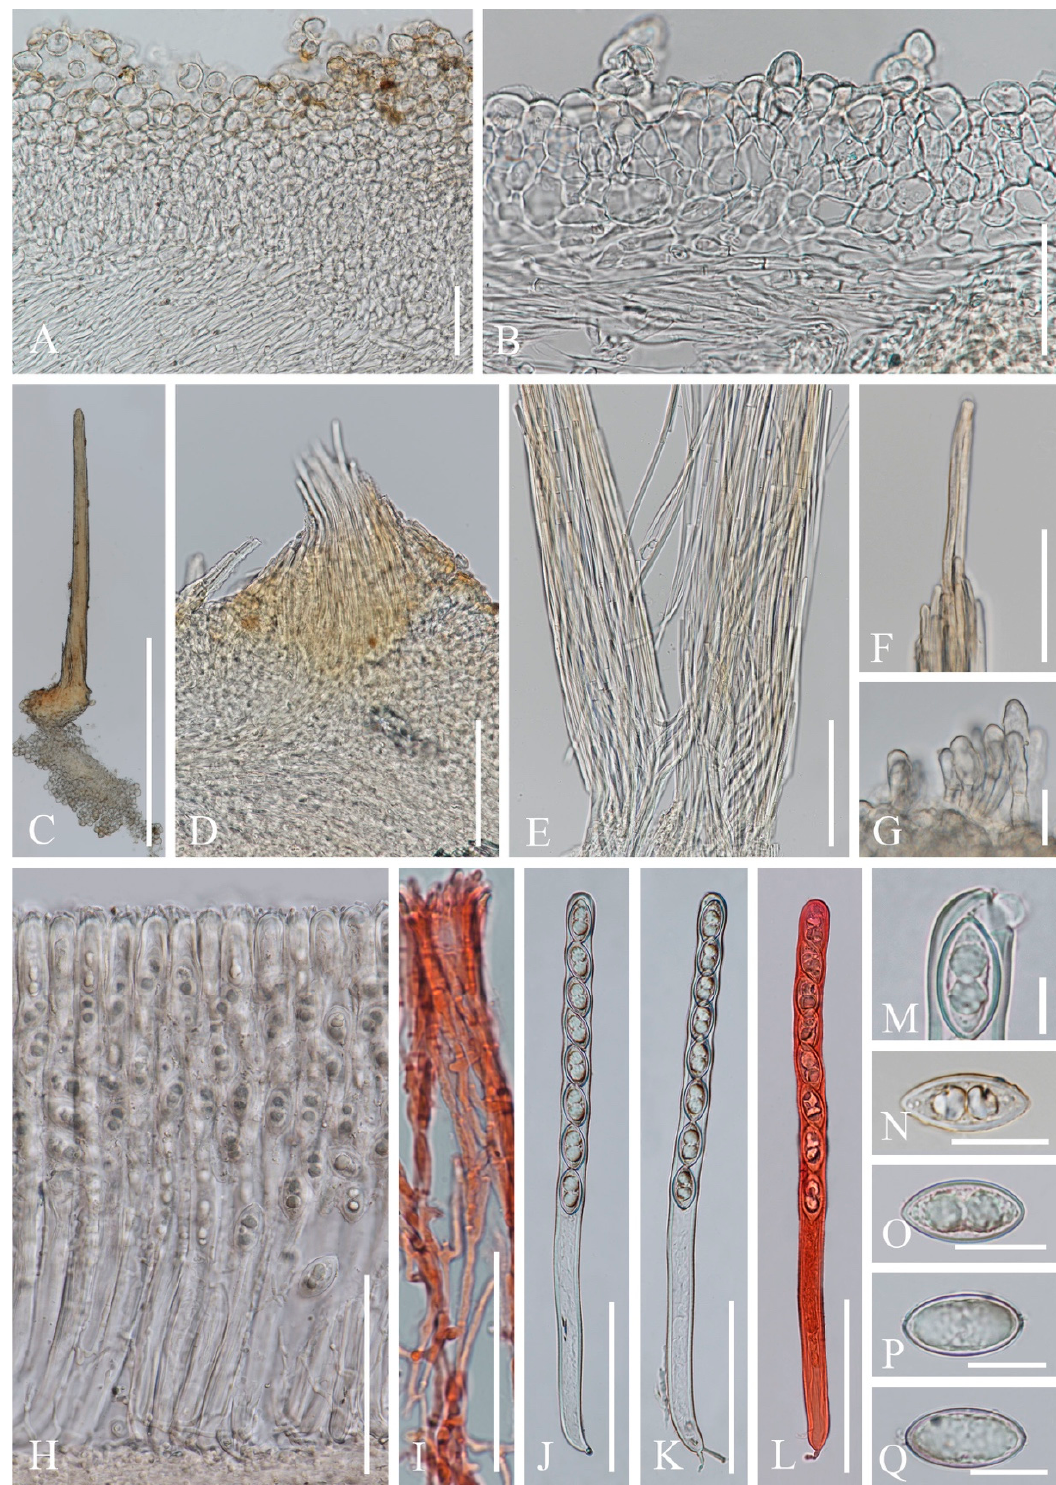
Figure 6. Cookeina sinensis (HKAS 121179). ( A ) Vertical section of stipe ectal excipulum. ( B ) Vertical section of receptacle ectal excipulum. ( C ) Compound hair. ( D ) Base of the compound hair arising from medullary excipulum. ( E ) Loose compound hairs. ( F ) Tips of compound hairs. ( G ) Hyphoid hairs. ( H ) Hymenium. ( I ) Paraphyses in CR. ( J – L ) Asci and ascospores ( L ) Ascus and ascospores in CR. ( M ) Apex of an ascus. ( N – Q ) Ascospores. Scale bars ( A , B , F , I ) = 50 μ m; ( C ) = 500 μ m; ( D , E , H , J – L ) = 100 μ m; ( G , N – Q ) = 20 μ m; ( M ) = 10 μ m. 3. Cookeina speciosa (Fr.) Dennis, Mycotaxon 51: 239 (1994); Figures 7–10 Index Fungorum number: IF 362244; Facesoffungi number: FoF 02675